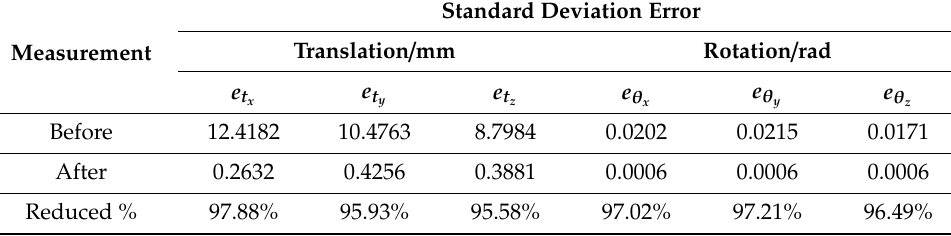
Table 4. Standard deviation error.